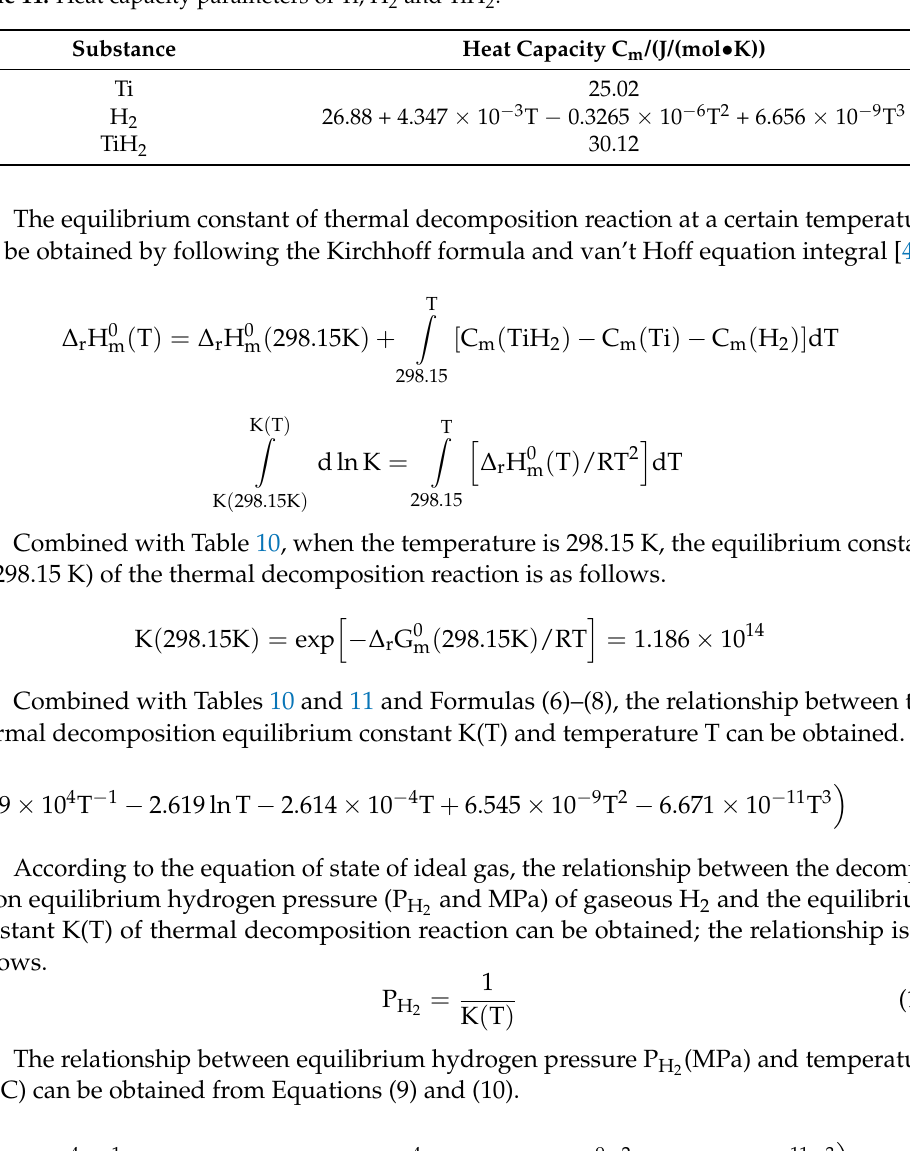
Table 11. Heat capacity parameters of Ti, H 2 and TiH 2